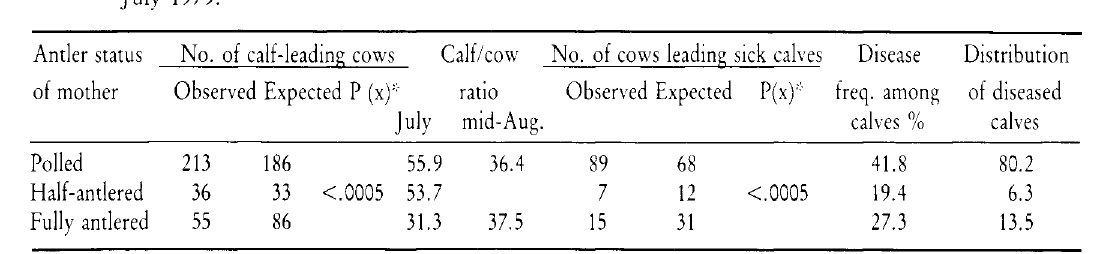
Table 2. Calf production and mortality parameters in relation to antler status of cows in the Sisimiut herd, July 1979. Antler status N o. of calf-leading